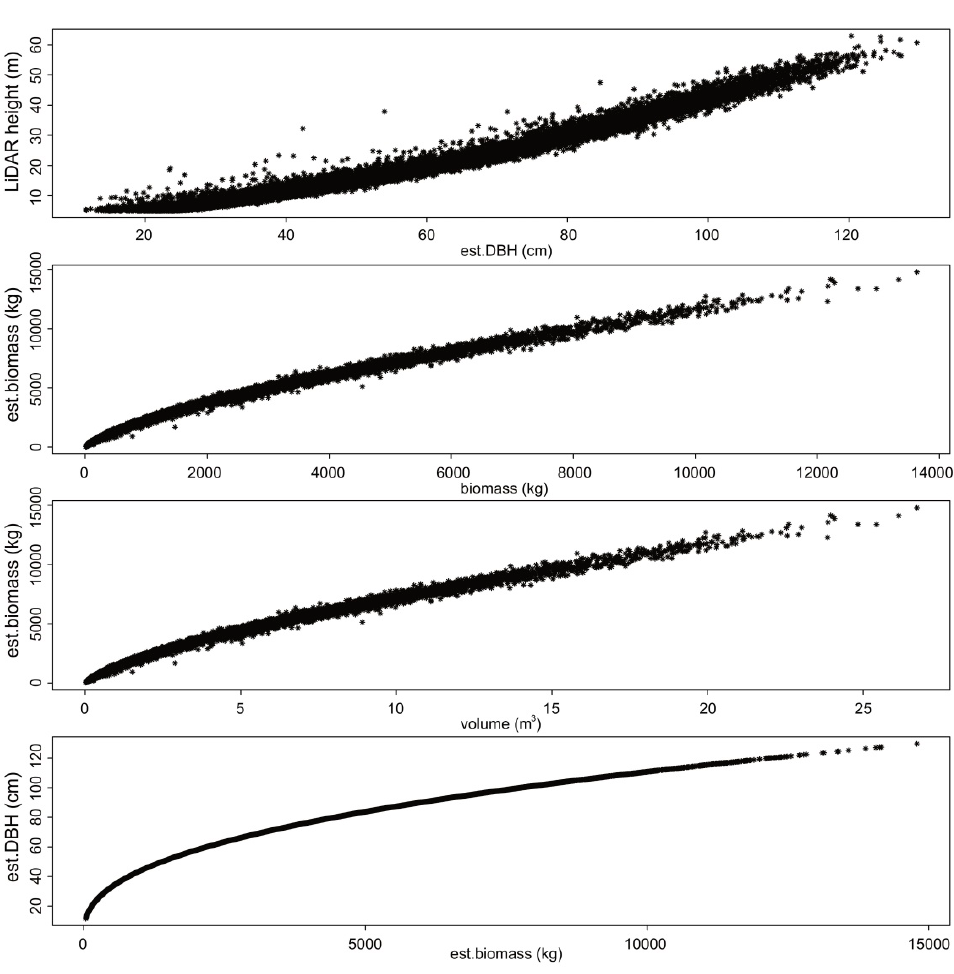
Figure A3. Final checks for the used model.